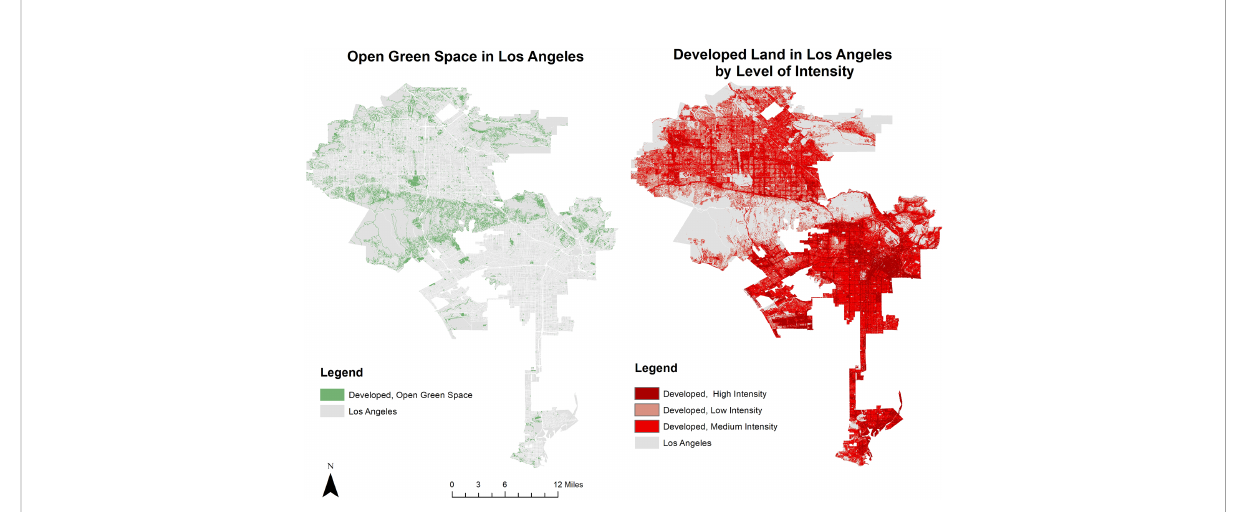
FIGURE 1 Comparing open green space and development intensity in Los Angeles,